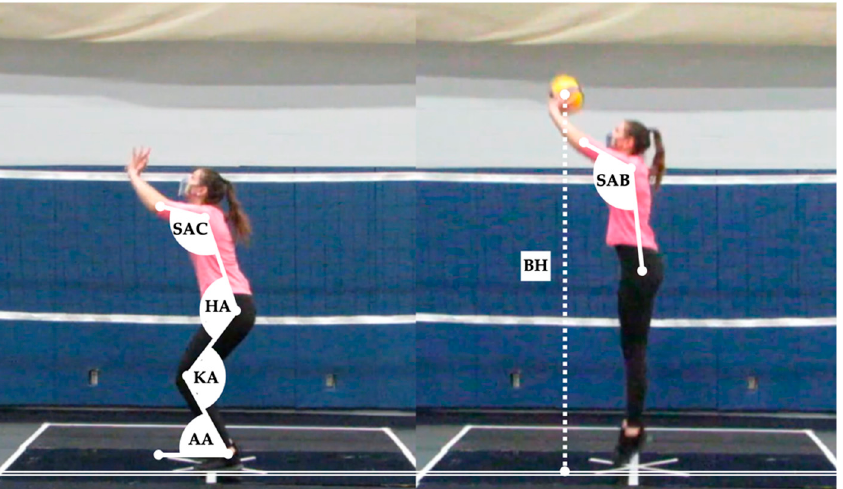
Figure 3. Graphical representation of kinematic variables examined in the present study. SAC = shoulder angle at the initial concentric phase of setting motion; HA = hip angle; KA = knee angle; AA = ankle angle; SAB = shoulder angle at the initial contact with the ball; BH = ball height.